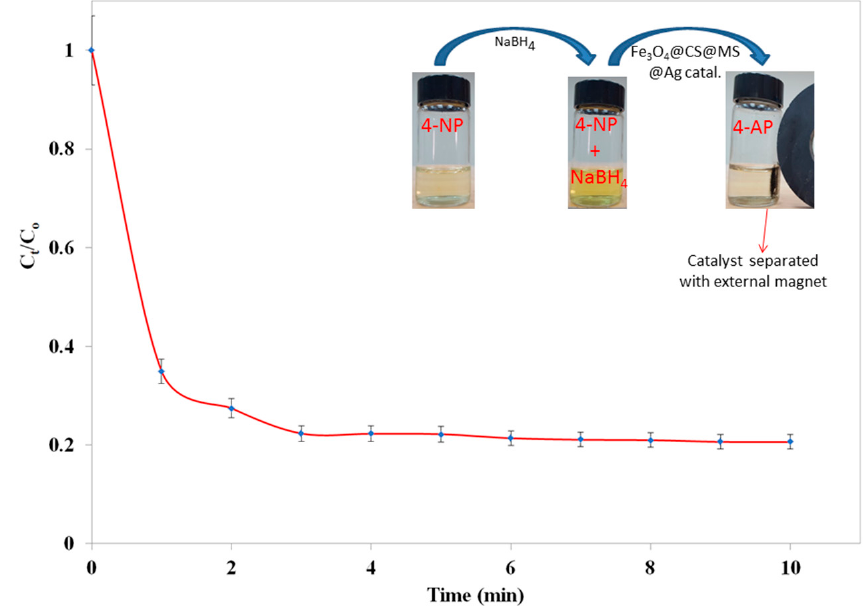
Figure 11. Relationship of C t / C 0 versus time for the reduction of 4-NP to 4-AP using 0.8 mg (6.5 × 10 − 7 mol Ag) of Fe 3 O 4 @CS@MS@Ag as catalyst.